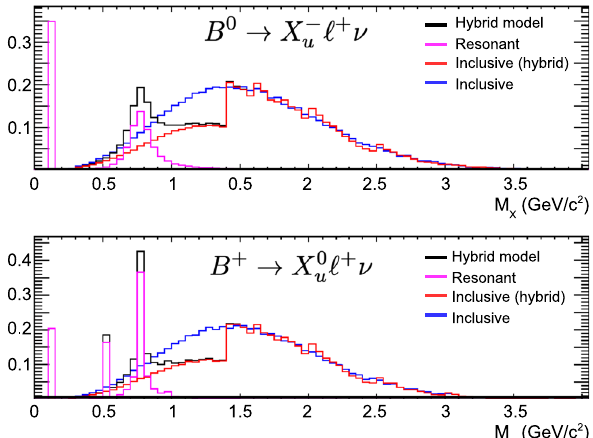
Fig. 9 Model of the hadronic invariant mass M X for the signal B → X u (cid:4)ν events, separately for B 0 (top) and B +